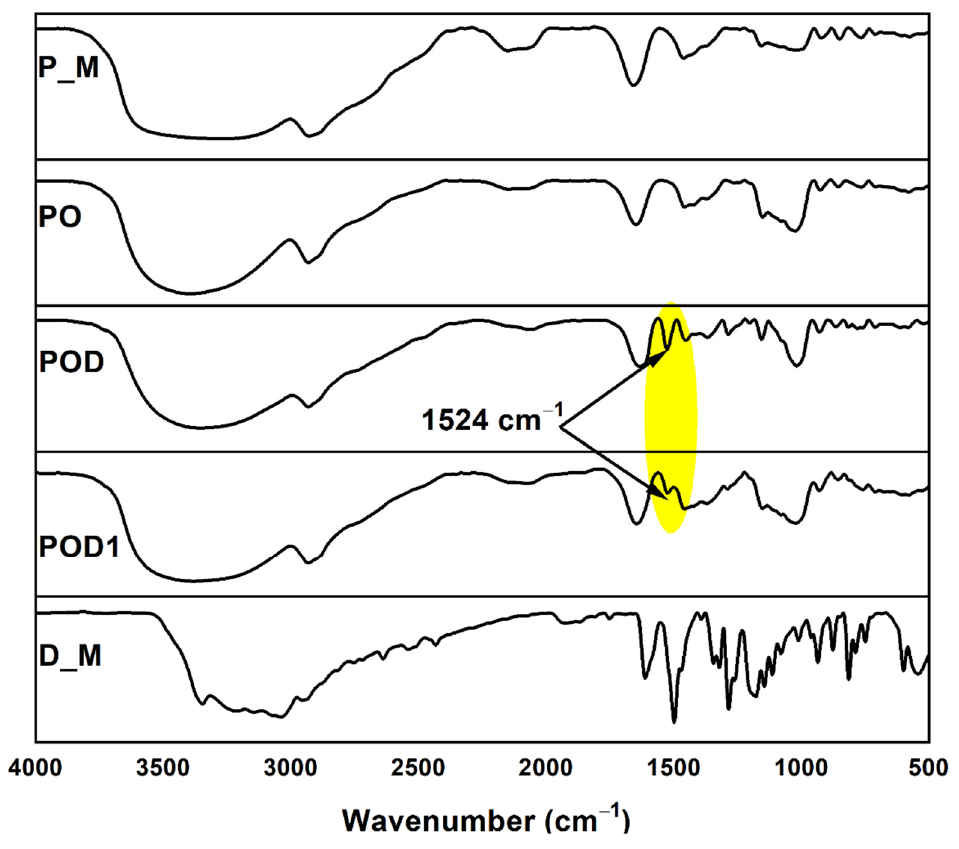
Figure 3. FTIR spectra of the raw polysaccharide, dopamine and the prepared cryogels.